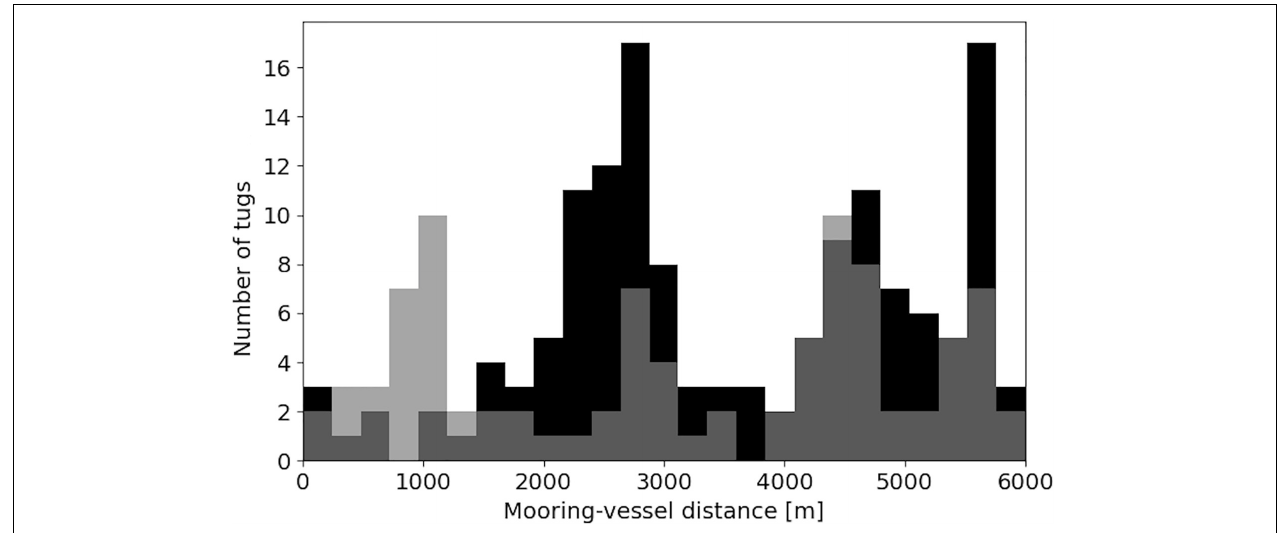
FIGURE 8 | Distribution of nearest approach distances for tugs as they passed the Jordan River mooring (positioned at zero) during the pre-trial period (light) and trial period (black). Darker gray represents where pre- and trial period results